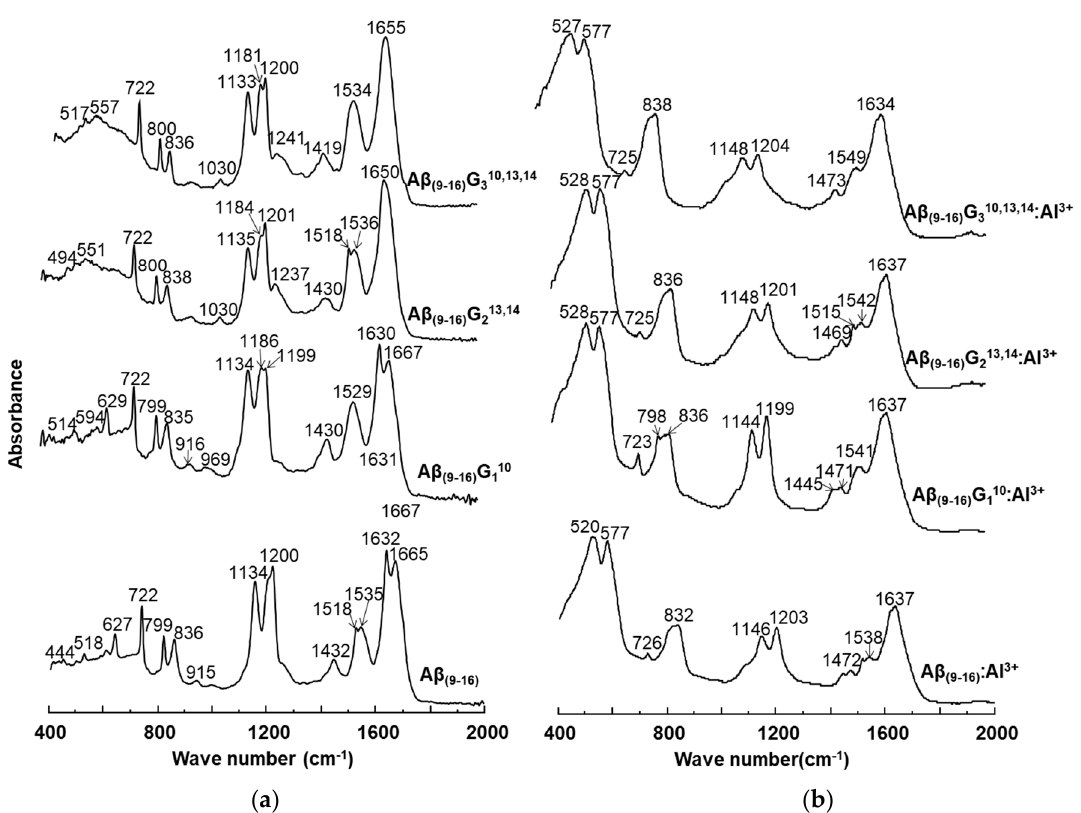
Figure 8. FT-IR spectra of the A β (9–16) amyloid peptide and its corresponding analogues that were recorded: ( a ) in the absence of aluminium ions; ( b ) in the presence of aluminium ions.